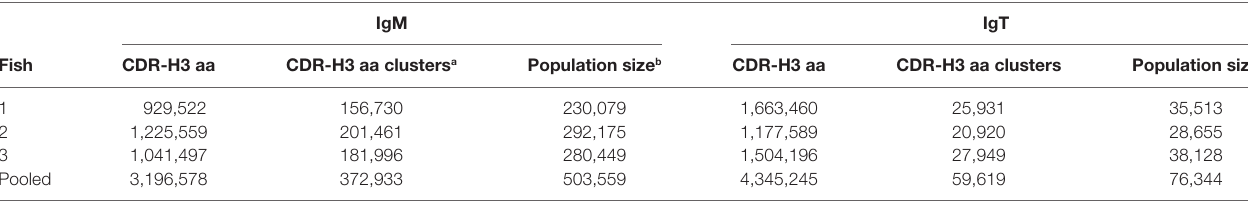
Table 3 | Heavy (H) chain complementarity-determining region 3 (CDR-H3) amino-acid (aa) clustering statistics. igM